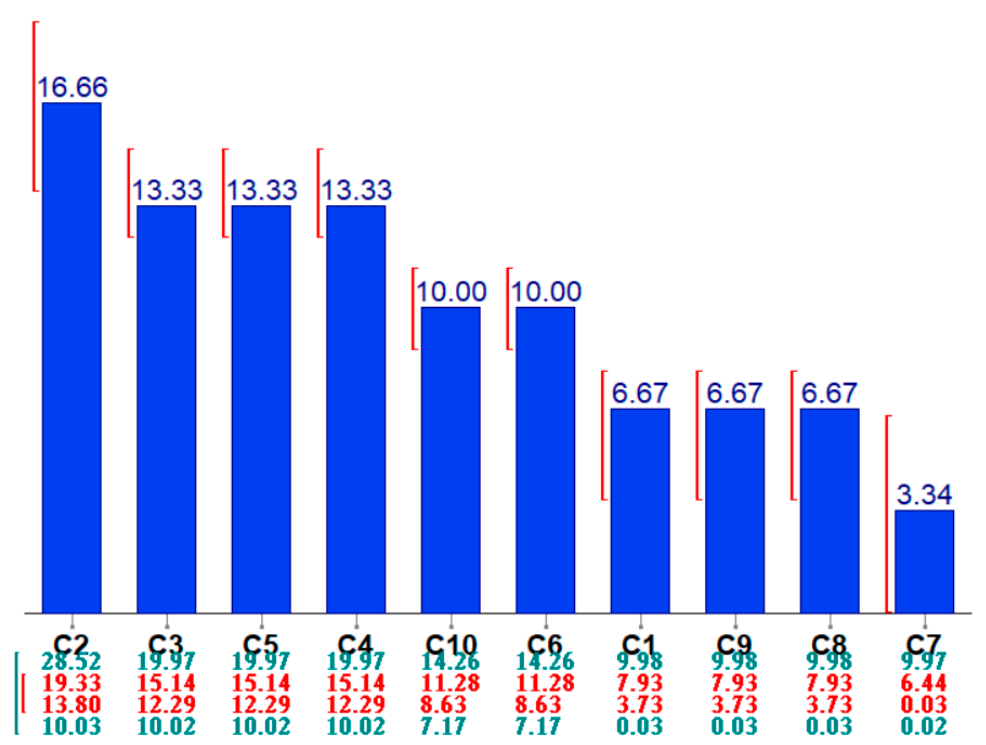
Figure 6. Weightings and value ranges consistent with the judgements given by the decision maker. Table 4. Weightings of the criteria obtained via the MACBETH approach in the form of triangular fuzzy numbers.